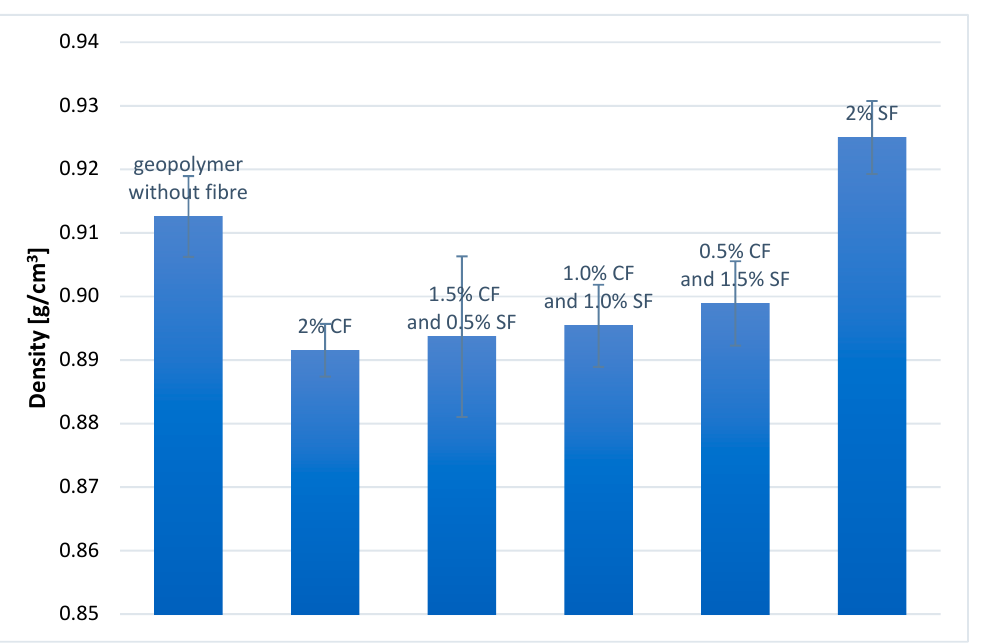
Table 3. Dimensions and weight of samples for testing thermal insulation properties.